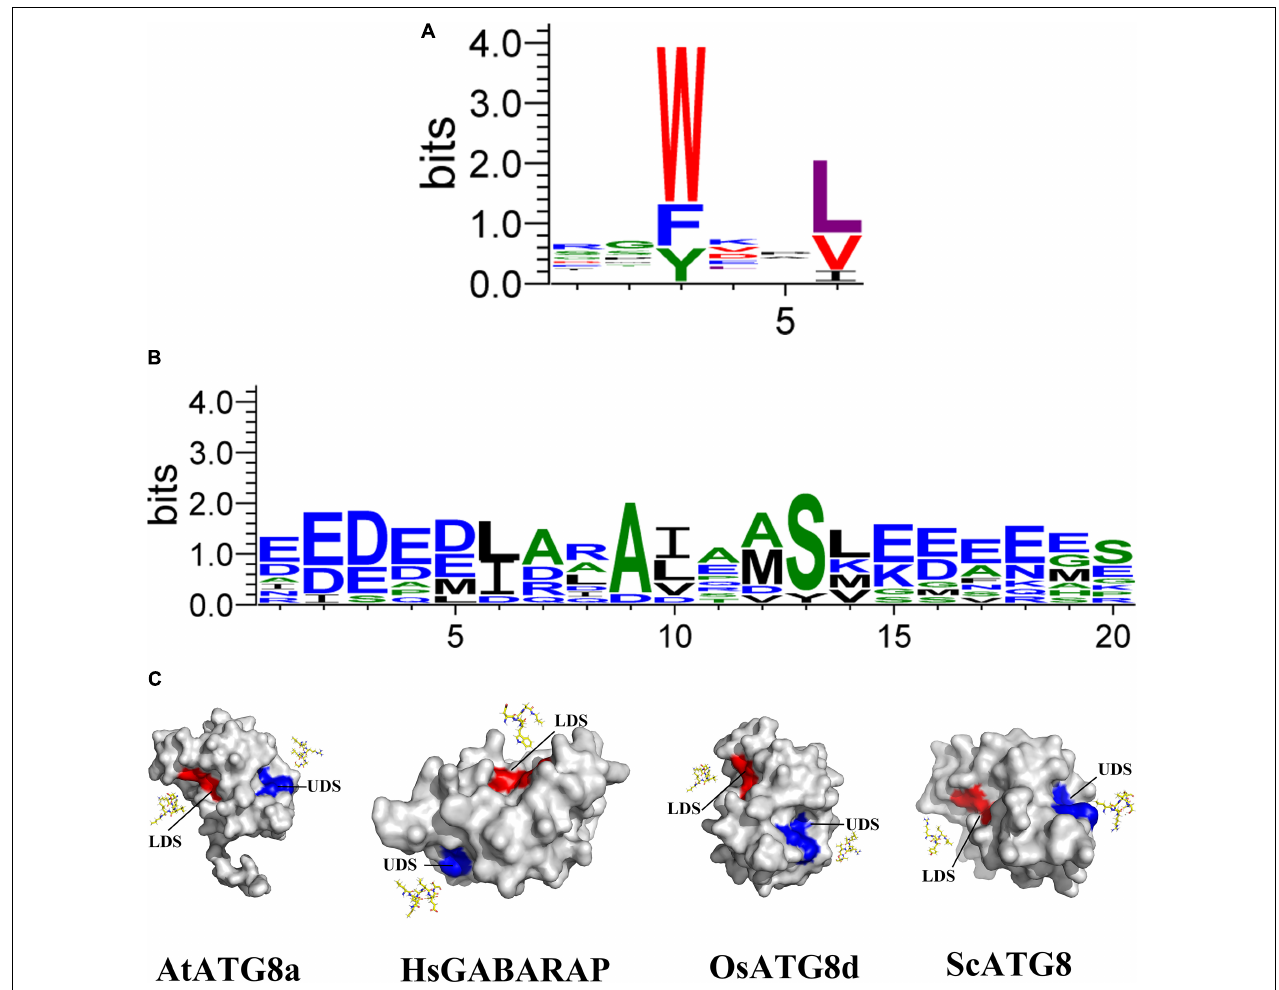
FIGURE 1 | Structures and binding motifs of the UIM docking site and the LIR/AIM docking site proteins. (A) The plant AIM consensus sequences are identified by WebLogo by using the known AIMs as shown in Table 2 . (B) The plant UIM consensus sequences are identified by WebLogo by using the known AIMs as shown in Table 1 . (C) Surface view of the three-dimensional structure of four ATG8 proteins corresponding to Arabidopsis thaliana , Homo sapiens , Oryza sativa , and Saccharomyces . Eight AIM-containing peptides shown in yellow stick form. Blue and red shading represent UDS and LDS, respectively. The structure of four proteins is derived from SWISS-MODEL database (Guex et al., 2009; Bertoni et al., 2017; Bienert et al., 2017; Waterhouse et al., 2018; Studer et al.,